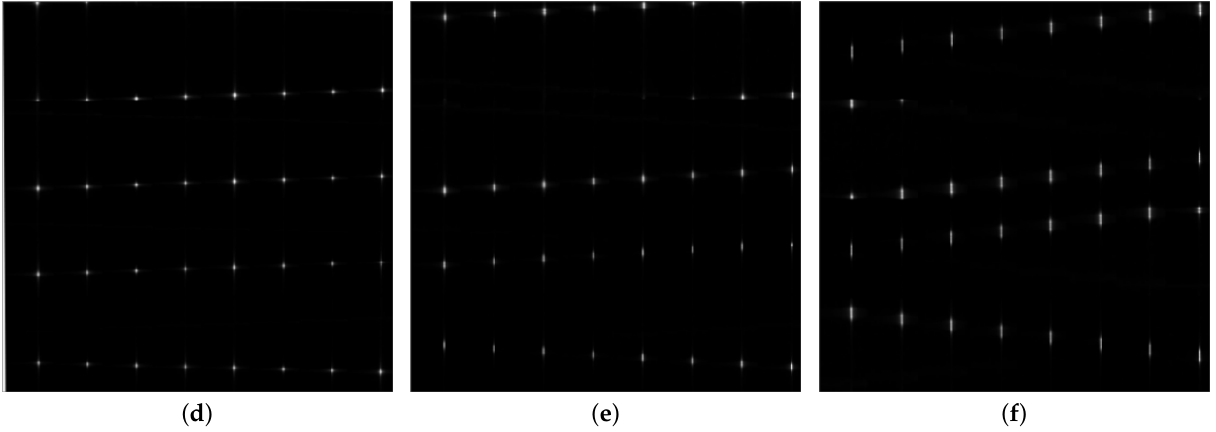
Figure 6. Feature images of triangle wave frequency modulation signals with different relative bandwidths. ( a ) SPWVD ( f foc = 0.02 ); ( b ) SPWVD ( f foc = 0.04 ); ( c ) SPWVD ( f foc = 0.08 ); ( d ) DR2D ( f foc = 0.02 ); ( e ) DR2D ( f foc = 0.04 ); ( f ) DR2D ( f foc = 0.08